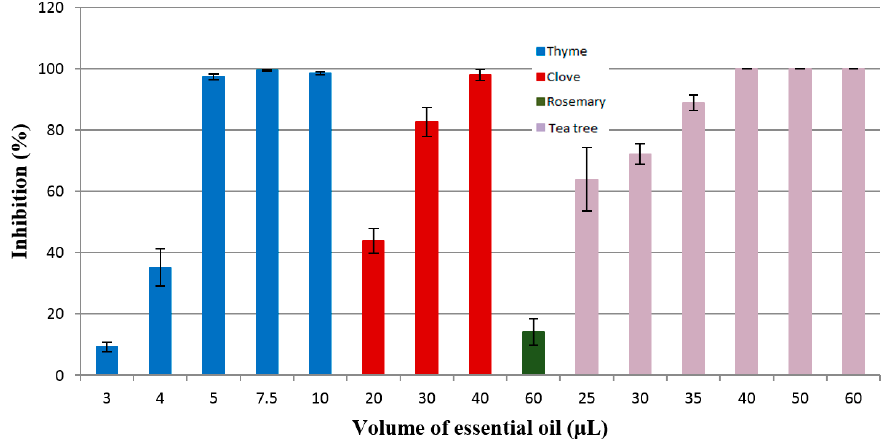
Figure 7. Inhibition of the Aspergillus brasiliensis ATCC 16404 growth by the thyme, clove, rosemary, and tea tree essential oils.